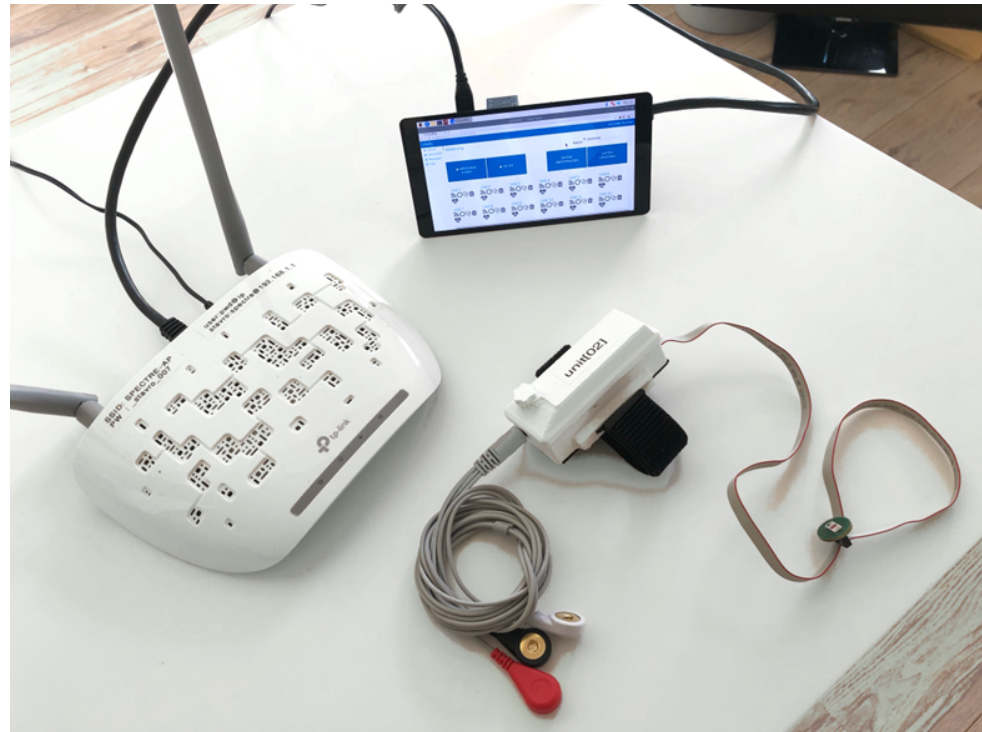
Figure 7. Systemsetup showing the control unit with touch display and graphical user interface, a router, and one SPECTRE 3.0 measuring